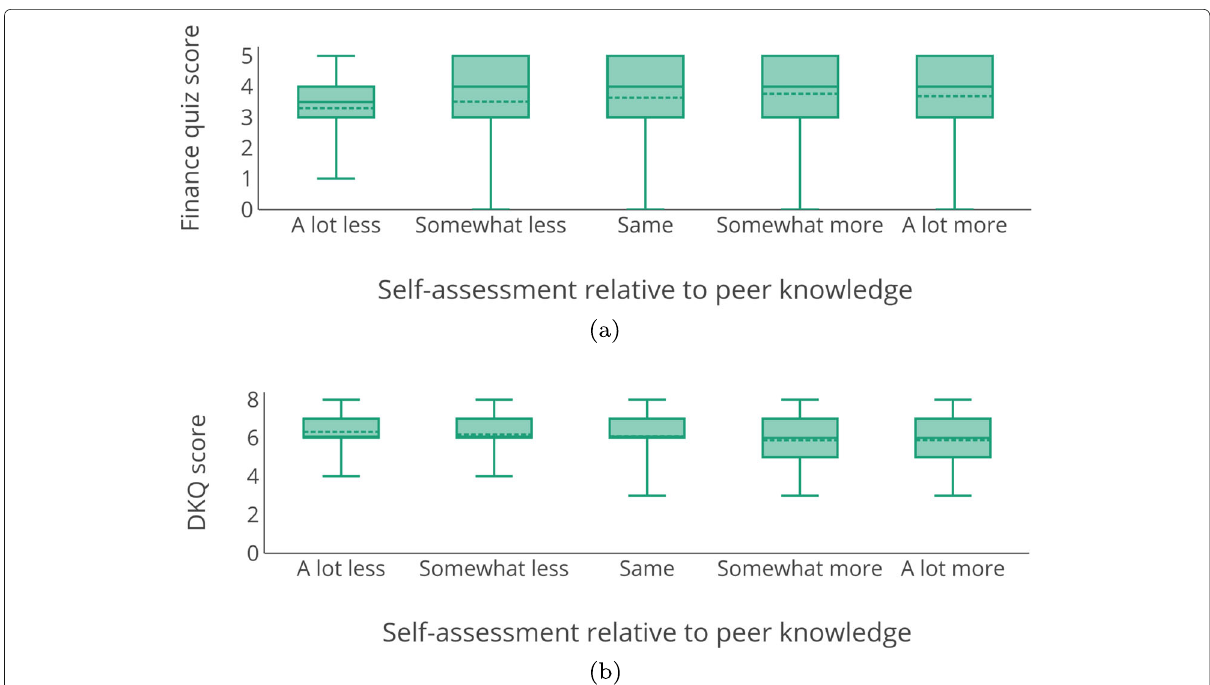
Fig. 9 Self-assessed vs. actual knowledge for the two domains tested. Plots show median ( solidline ), mean ( dashedline ), and minimum/maximum. a Finance. b